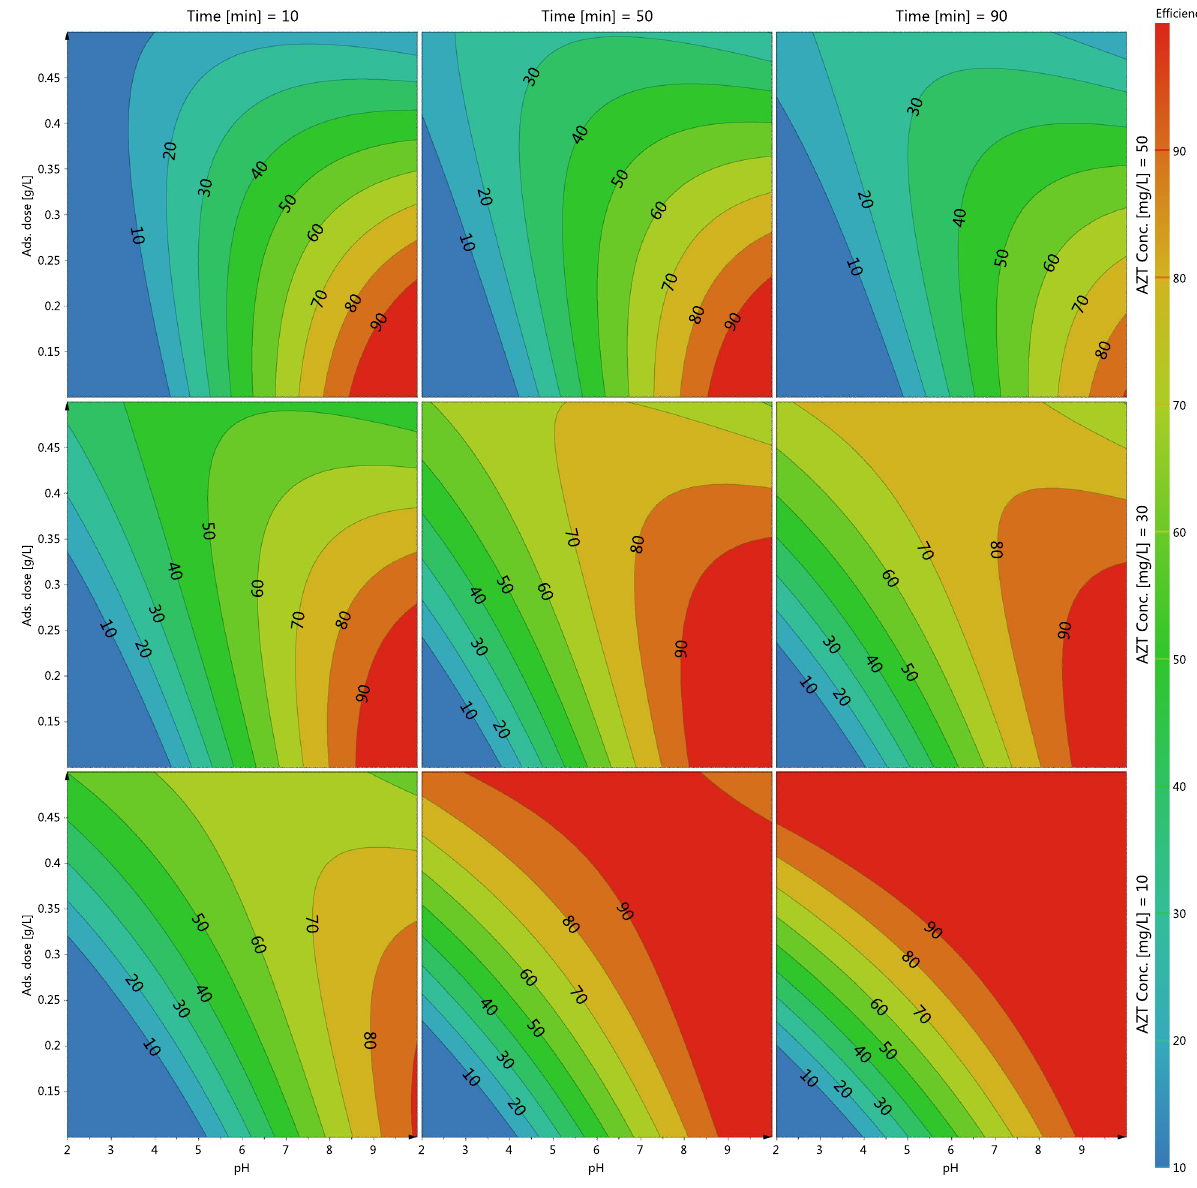
Figure 3. 4D plots of variables effect on AZT